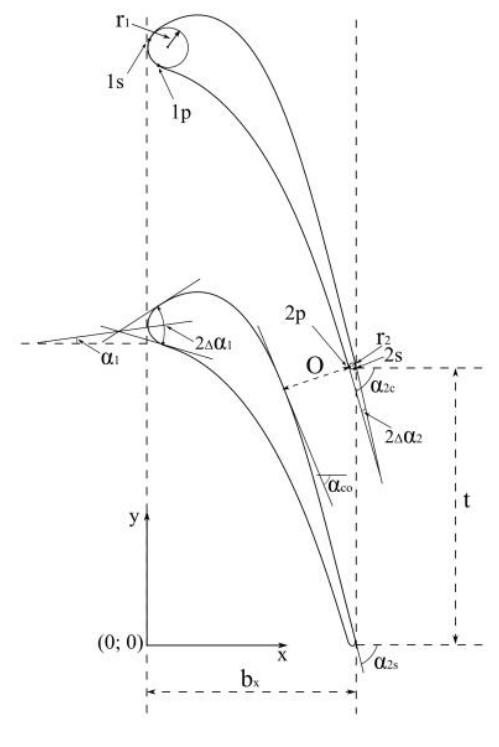
preliminary calculation of geometrical characteristics